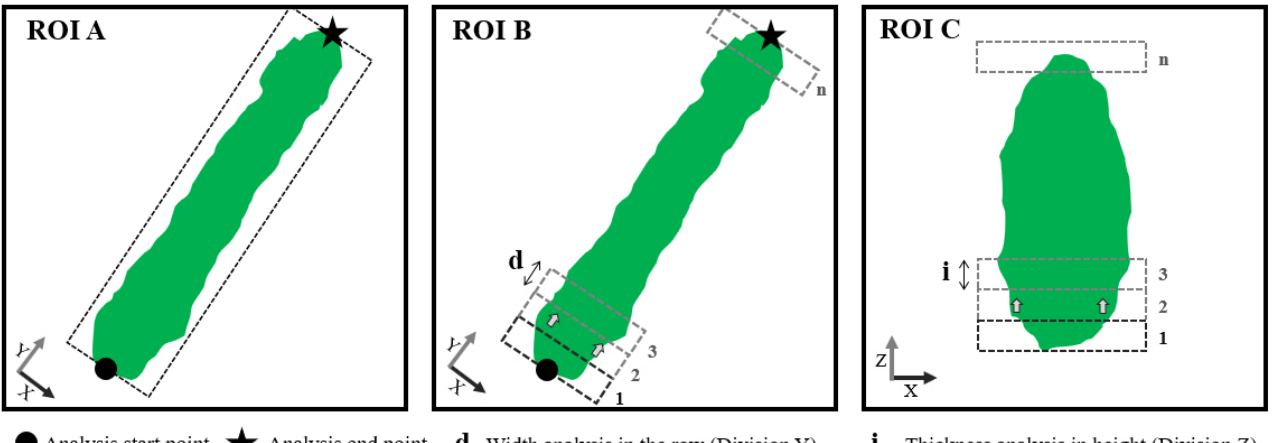
Figure 2. Regions of interest that consider the LiDAR data processing algorithm for extraction of structural and geometric orchard parameters along the tree rows (adapted from [27]. ROI ‐ A and ROI ‐ B are zenithal views, ROI ‐ C is a cross ‐ sectional view.